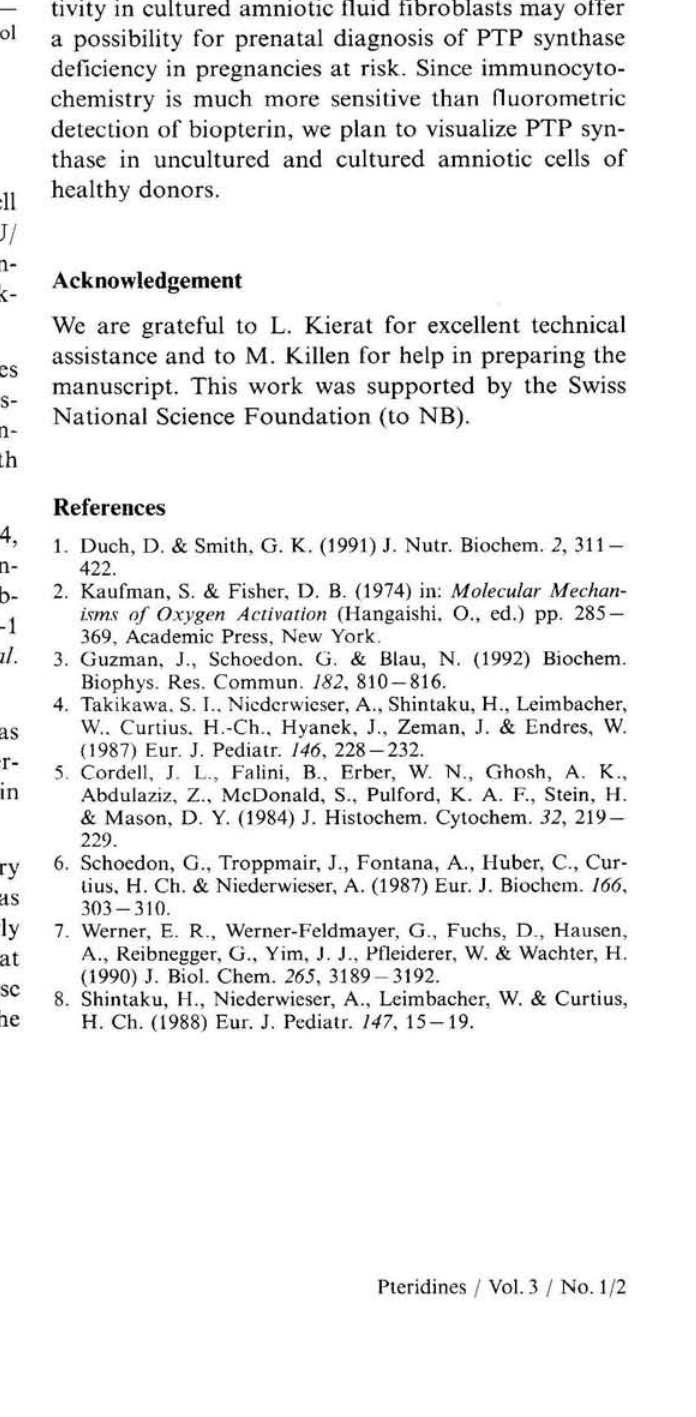
Table 1. PTP synthase activity in different cells. Cells Activity Ref. η μυ/mg protein SK-N-BE 24.3/23.8 2 BJA-B 32.0/31.4 2 GH4C1 38.6 1 Namalwa n.d. 5 Molt-4 48.0 1 THP-1 0.397 + 0.036 7 5 0.349 + 0.055* 7 5 T-24 7.63 + 0.77 7 5 7.86 + 0.34* 7 5 Fibroblasts 4.0 ± 0.12 7 Macrophages human 0.2** 1 mouse 0.4**